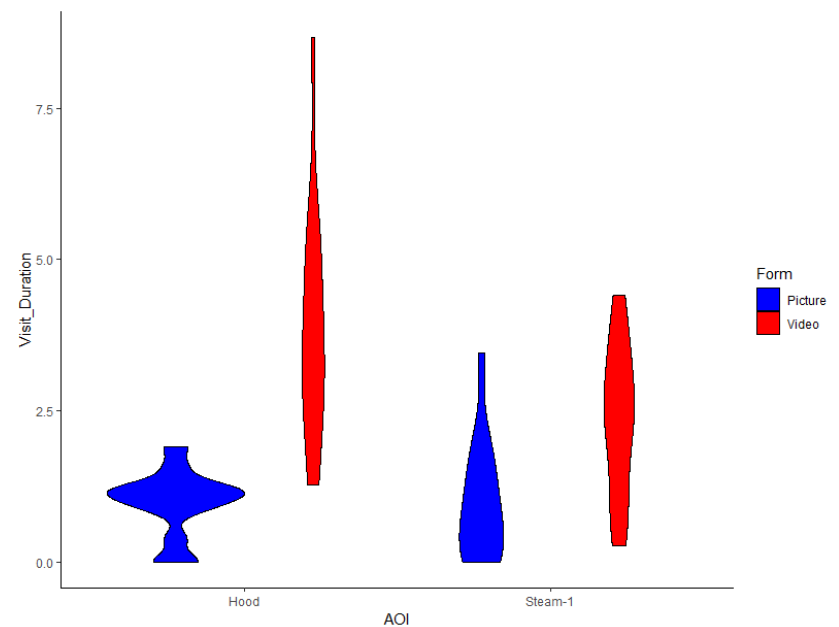
Figure 9. Violin plots highlighting the most significant differences on TVD Diff% between forms of representation for the product Hood.